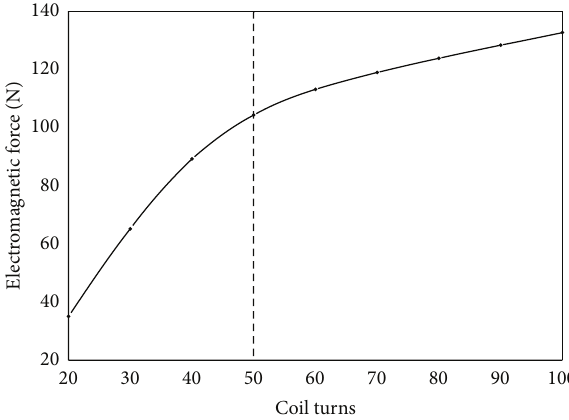
Figure 11: Influence of coil turns on electromagnetic force.